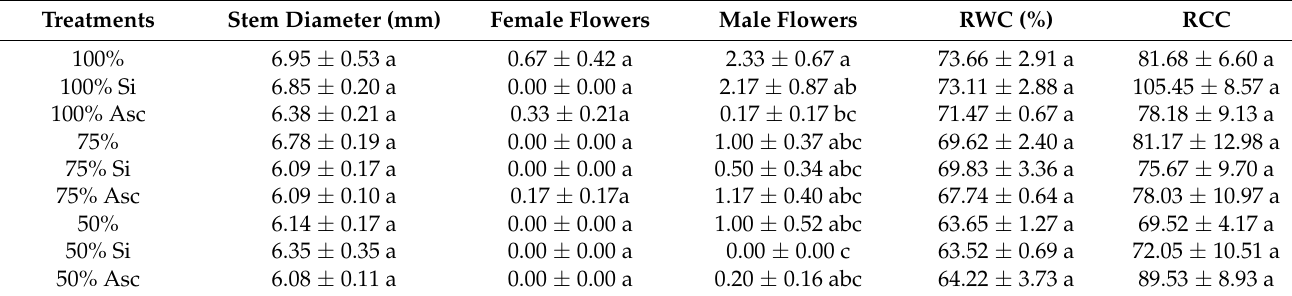
Table 1. Developmental and physiological parameters of watermelon plants 20 days after transplan- tation treated with two biostimulants (Si: silicon-based, and Asc: Ascophyllum nodosum seaweed) and additionally irrigated with different amounts of nutrient solution. Mean values ( n = 6; ± SE) within a column followed by different letters are significantly different (a < 0.05). RWC: relative water content; RCC: relative chlorophyll